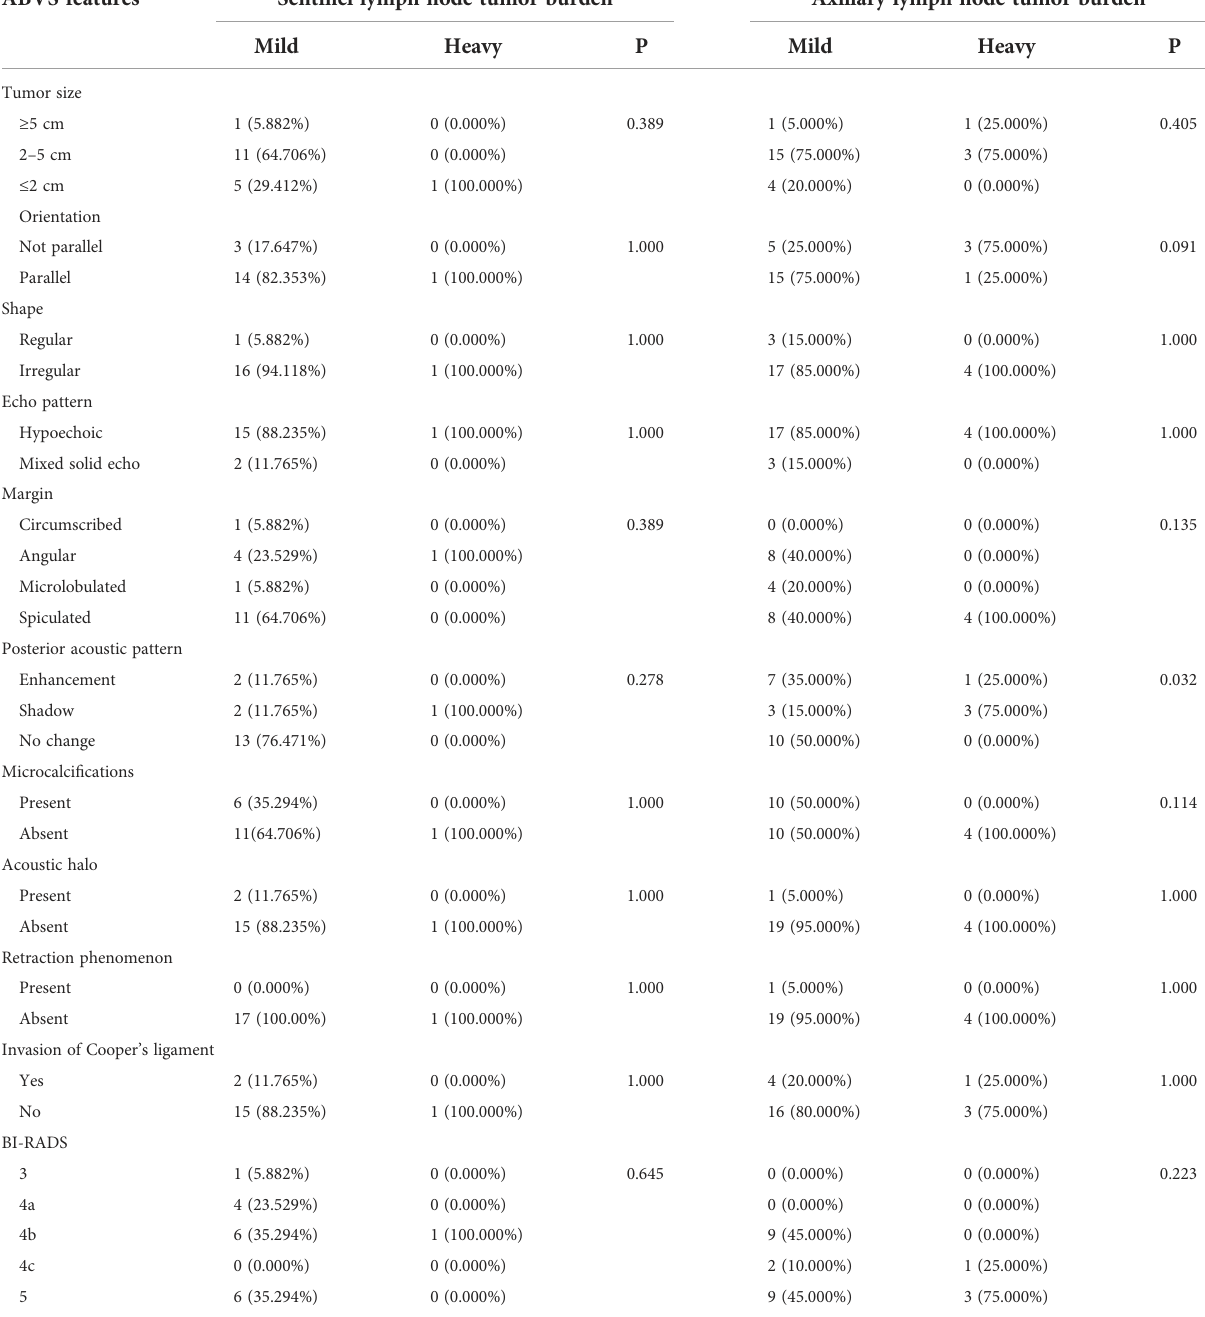
TABLE 4 Differences of lymph node tumor burden of HER-2 overexpression type breast cancer regarding different ABVS